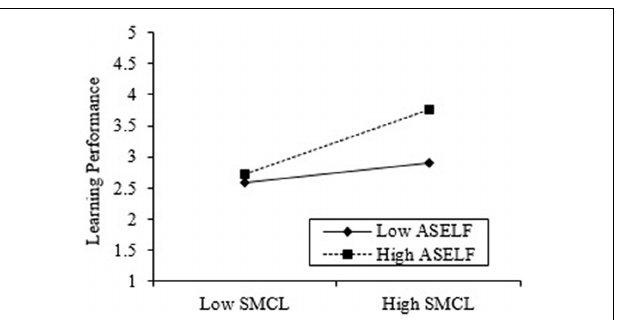
FIGURE 2 | Moderating effect of academic self-efficacy with the relationship of social media learning collaborative and learning performance. SMCL, social media learning collaborative; ASELF, Academic